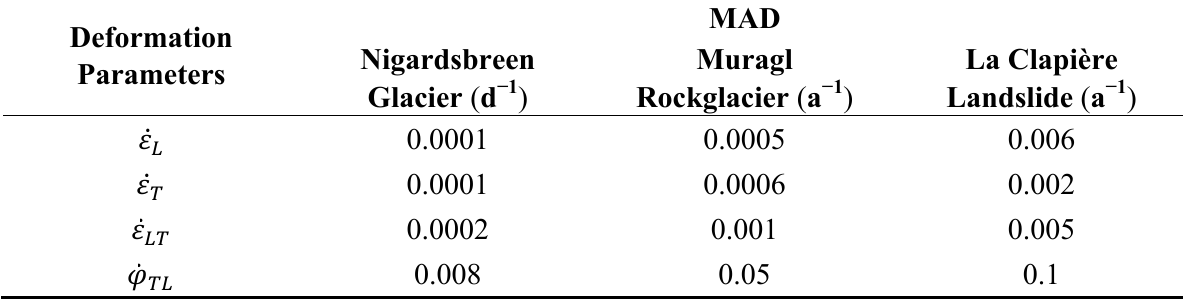
computed on the stable grounds of the three mass movement